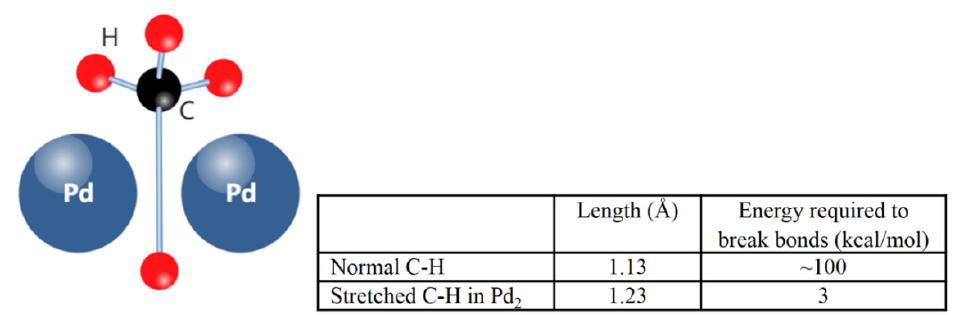
Figure 9. The optimum state of adsorbed methane on Pd 2 catalyst surface (bridge model) with related bond energy data [33].